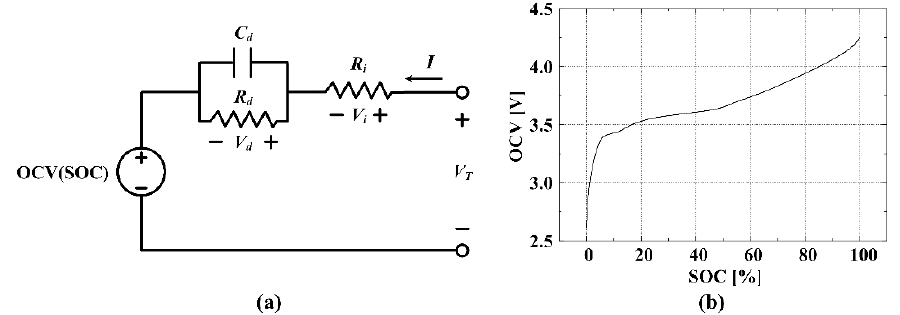
Figure 5. ( a ) Equivalent circuit of the Li-ion battery cell and ( b ) OCV (state of charge (SOC)): OCV versus SOC characteristic of the experimental Li-ion cell.